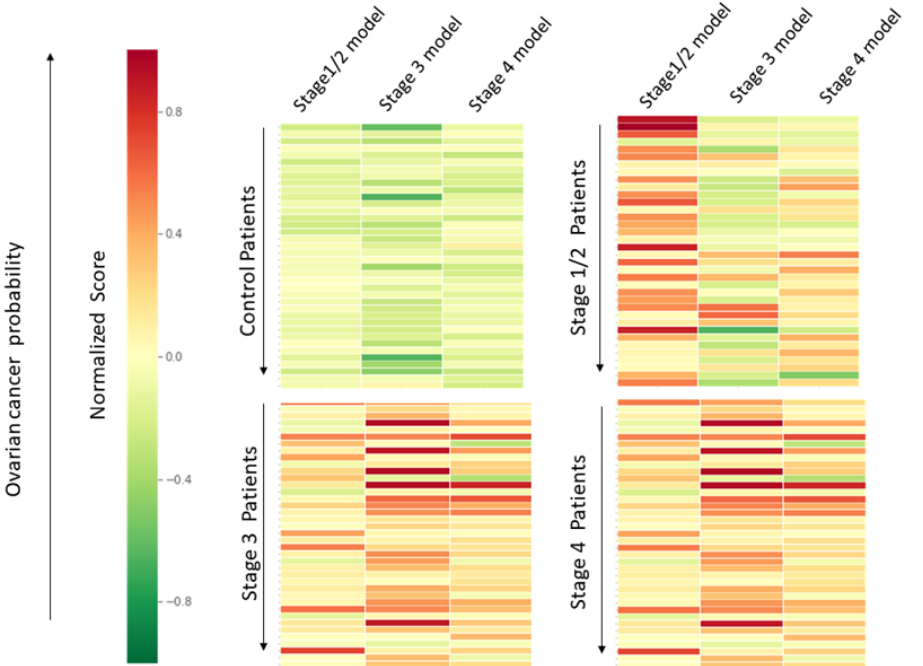
Figure 7. Comparison of the predictive scores of controls and those diagnosed with distinct cancer stages using the SA-based stage-specific models. Scores were normalized to reflect the deviation from the cutoff value within the maximum score values detected (maxScore) with the mathematical expression (patient score − cutoff)/maxScore. Value of zero indicates that patients’ scores are equal to the model cutoff, positive values above cut off, and negative values below cutoff. Values 1 and −1 indicate that patient scores are the maximum score observable. Scores of patients and controls are shown as grouped heatmaps and the colors indicate the normalized scores. Red indicates the highest score and green the lowest score for predicting cancer using a stage-based model. The correlated probability of cancer based on scoring is indicated as an arrow next to the color gradient legend. Low probability starts from dark green and ends in high probability at dark red.